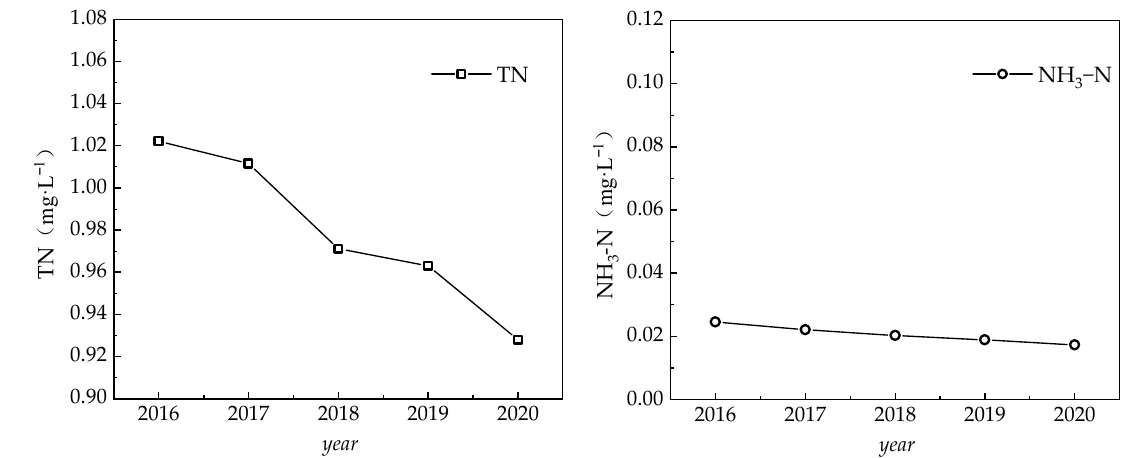
Figure 7. Accuracy of linear relationship between predicted and measured TN and NH 3 -N concentrations.